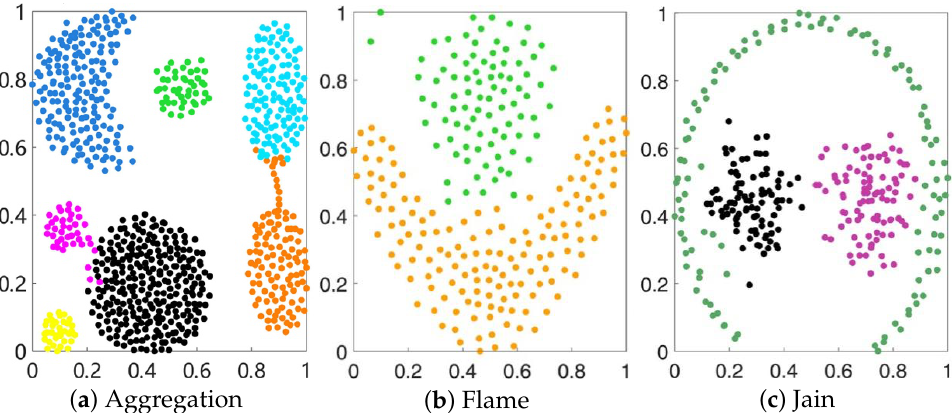
Figure 5. Clustering effect of the SNN-DPC algorithm on Aggregation, Flame, and